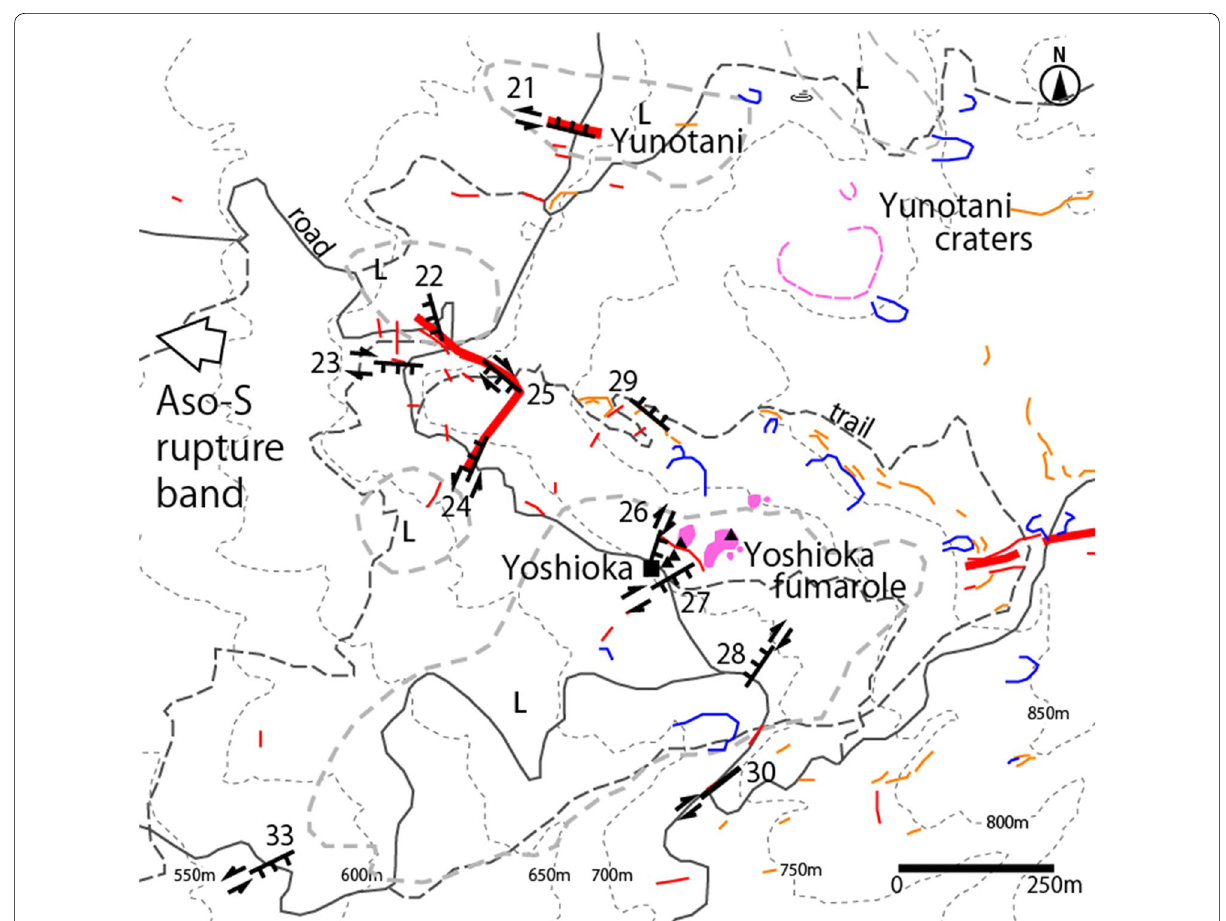
Fig. 11 Relationship of ruptures distribution and fumaroles shown by a geomorphological map of the area around Yoshioka fumarole. The legends of Kumamoto earthquake are shown in Fig. 10. Marks denote areas of damaged plants ( pink ), fumaroles ( solid triangles ), and hot water sources ( solid squares ) shown in Terada et al. (2007). Grey dashed line marked by L denotes possibility of landslide topography prior to the Kumamoto earthquake, as shown in Geospatial Information Authority of Japan (1994). The Yunotani craters are shown in Ikebe and Fujioka